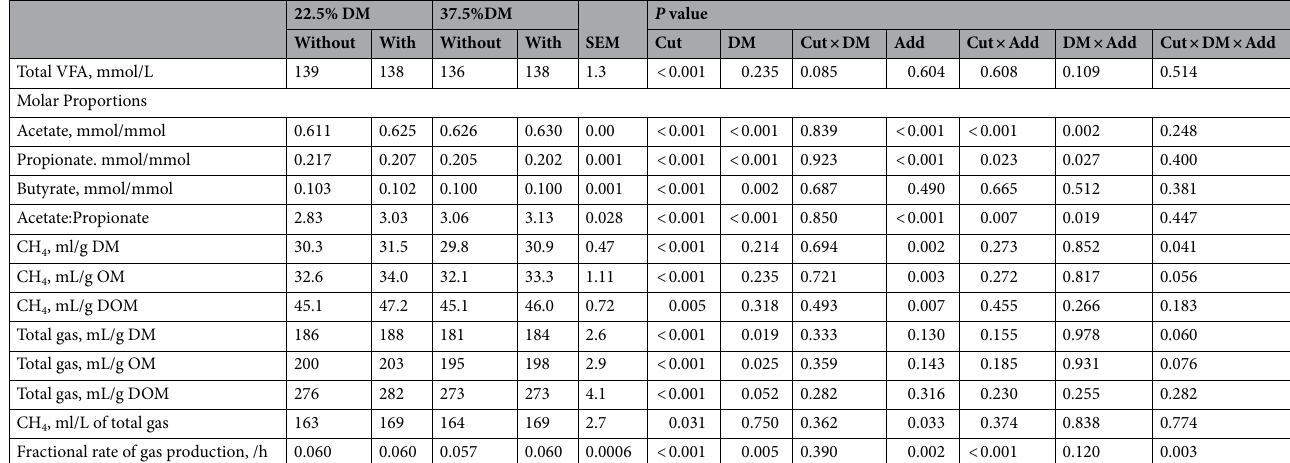
Table 7. Effect of wilting rate (target 22.5% or 37.5% DM) and silage additive (without or with) on silage in vitro rumen fermentation characteristics (total volatile fatty acids (VFA) and acids as molar proportion